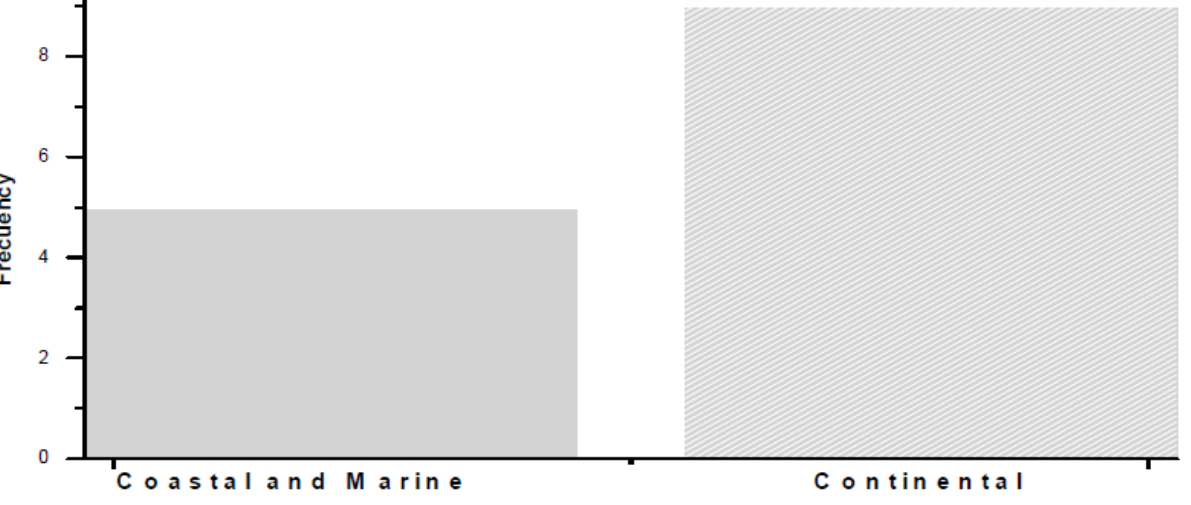
Figure 15. Classification of Wetlands Affected Globally.